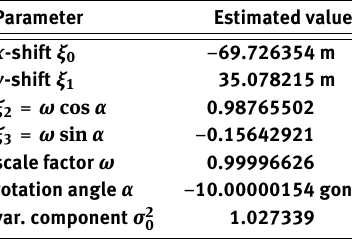
Table 3. Weighted TLS residual predictions for the 2-D similarity transformation, generated by both Algorithms 3 and 4